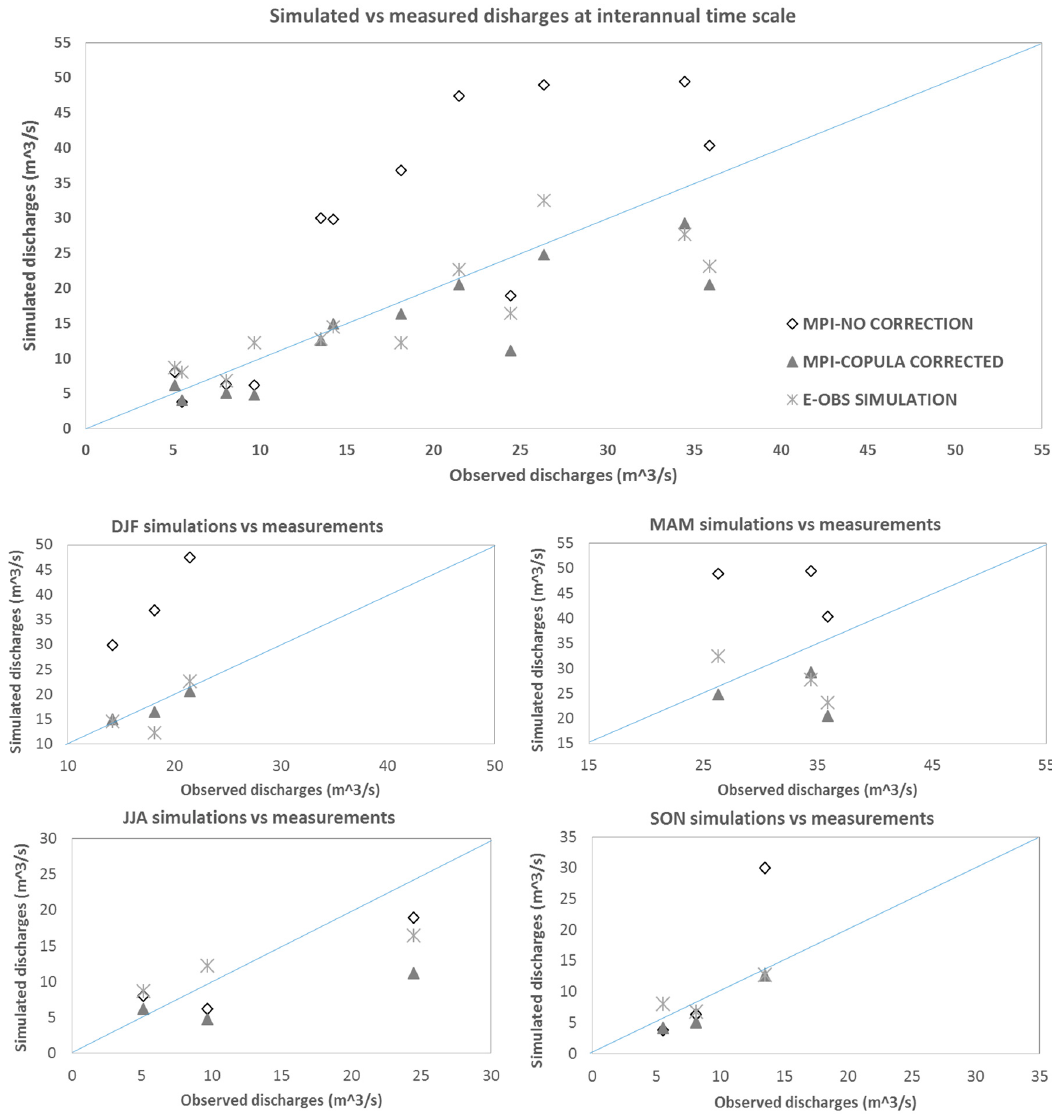
Figure 11. Simulated versus observed discharges at interannual and seasonal time scales.